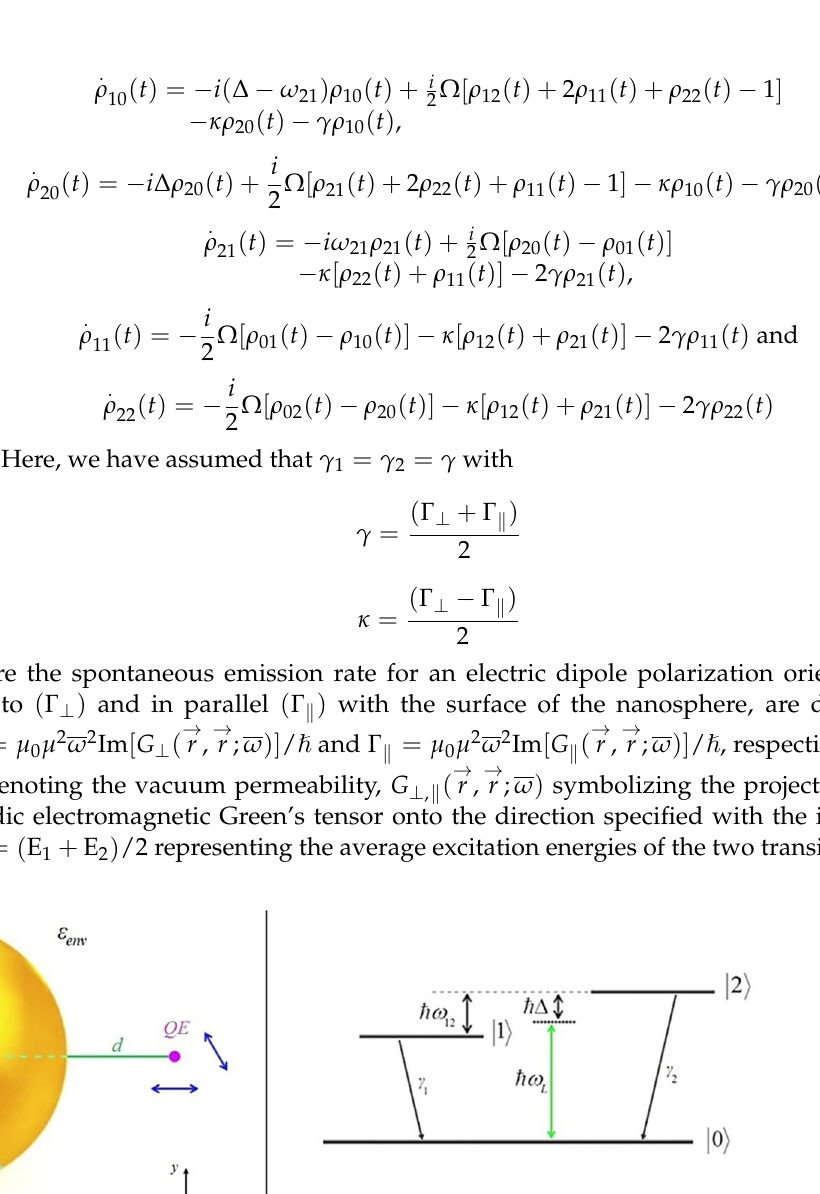
ε = . The al- env . The L ω  , Δ and ( 1, 2) γ = i , respec- 21 i